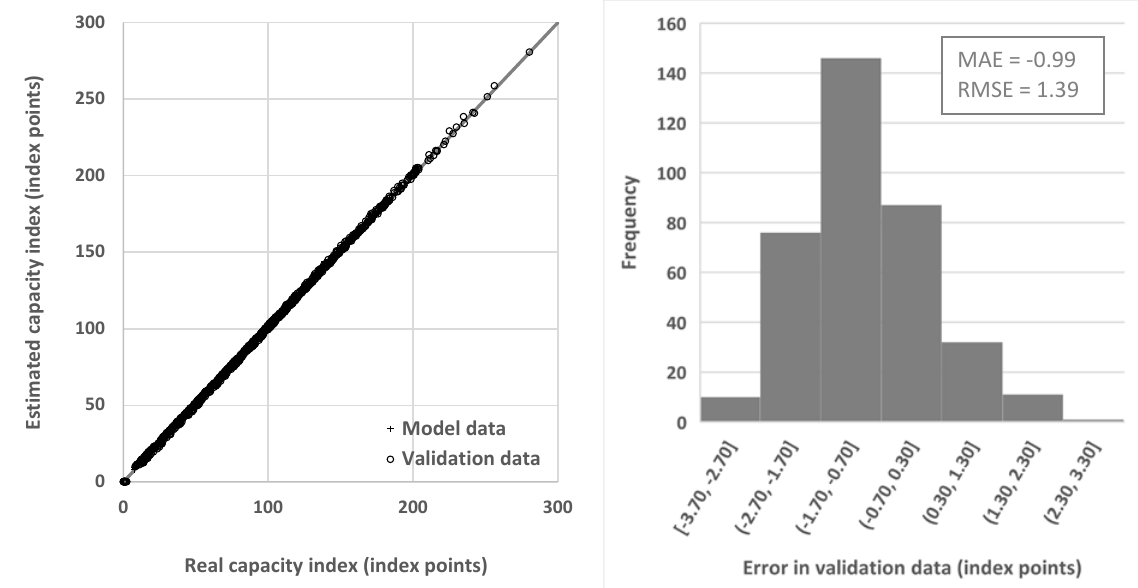
Figure 8. General model validation and histogram of error terms